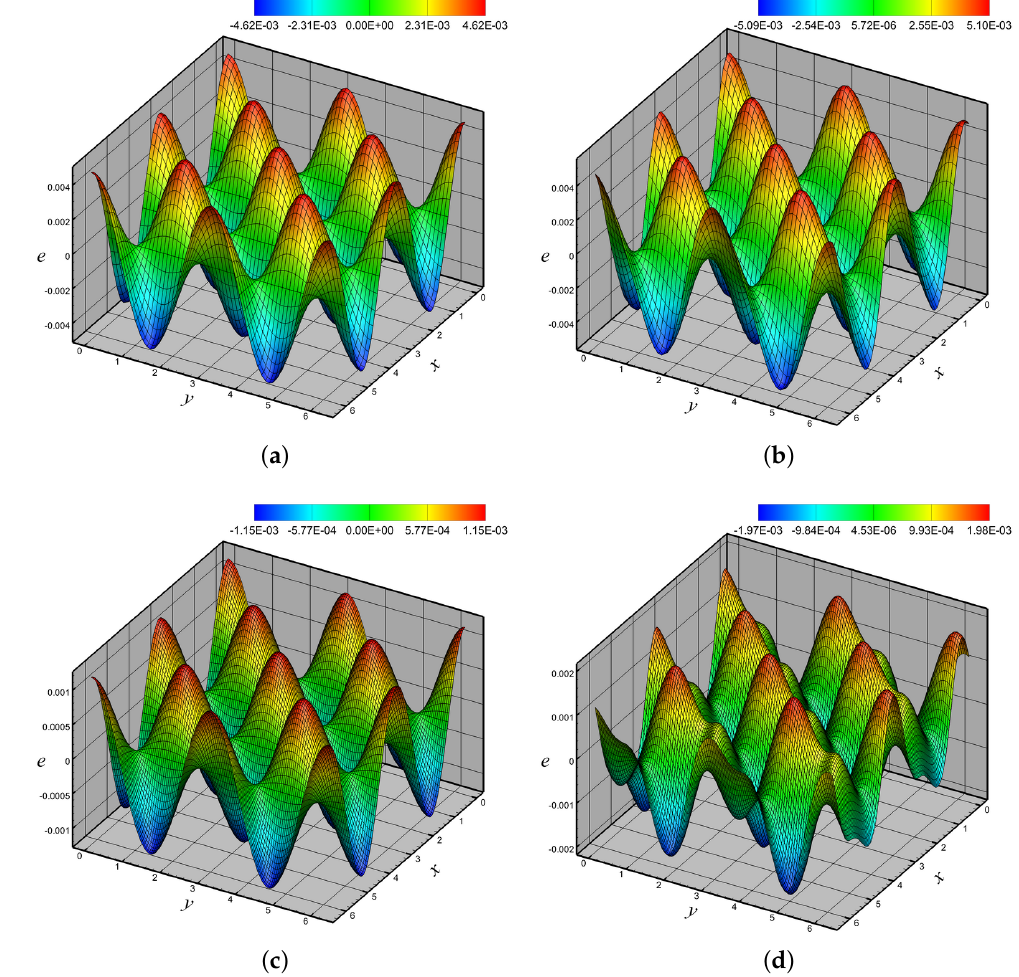
Figure 10. Comparison of the FOM and HA-ROM (i.e., R = 1) solutions at t = 1 for the TGV problem at Re = 10. Required CPU times for the FOM simulations are 137.9375 s (64 2 ) and 2156.2968 s (128 2 ). However, the HA-ROM computations require only 1.0156 s (64 2 ) and − ω Exact ); − ω Exact ); ( b ) error (i.e., e = ω HA − ROM 4.0625 s (128 2 ) CPU time; ( a ) error (i.e., e = ω FOM 64 2 64 2 − ω Exact ); ( d ) error (i.e., e = ω HA − ROM − ω Exact ( c ) error (i.e., e = ω FOM 128 2 128 2